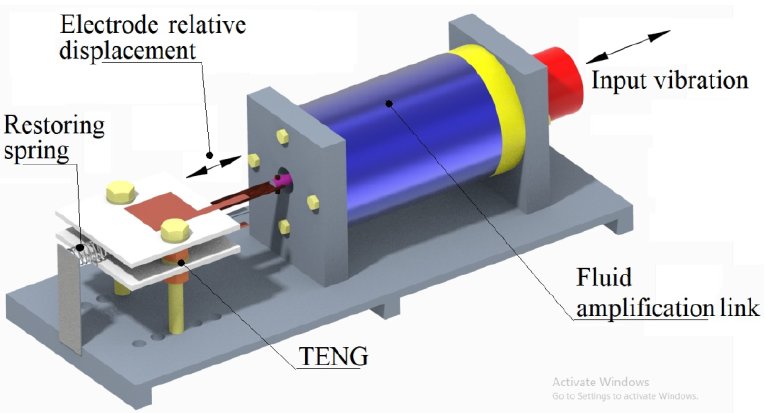
Figure 3. CAD model of the prototype energy harvester.